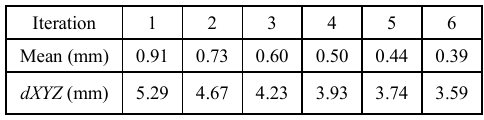
Table 4. The absolute spatial accuracies of each iteration of Trial A